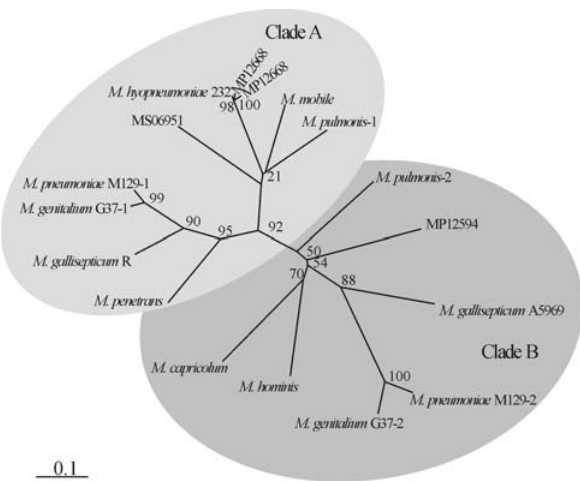
Figure 2 - Phylogenetic tree illustrating the relationships of L33 proteins. Sequences were aligned and subjected to phylogenetic analysis by using the minimum evolution (neighbor-joining) method. Numbers on branches indicate bootstrap values obtained for 100 replications. ORF identifica- tions of M. synoviae , M. hyopneumoniae J, and M. hyopneumoniae 7448 are referred in Table 1, and the amino acid sequences are available at Mycoplasma databases. Other L33 protein sequences obtained were: M. capricolum (GenBank: Z33076_REGION: 279..440); M. gallisepticum A5969 (GenBank: L35043_REGION: 269..415); M. gallisepticum R (GenBank: AE016969_REGION: 9206..9367); M. genitalium G37-1 (GenBank: U39713.1:9938..10099); M. genitalium G37-2 (GenBank: U39684 L43967_REGION: 14657..14803); M. hominis (GenBank: AF443617_REGION: 2827..2976); M. hyopneumoniae 232 (GenBank: